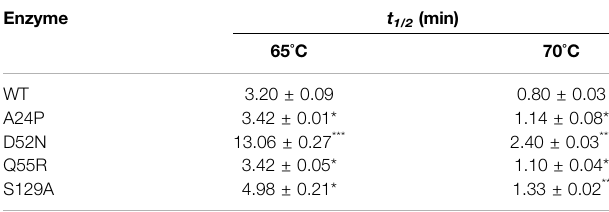
TABLE 2 | Half-life ( t 1/2 ) values of wild-type (WT) and mutant pepsin. Enzyme t 1/2 (min)